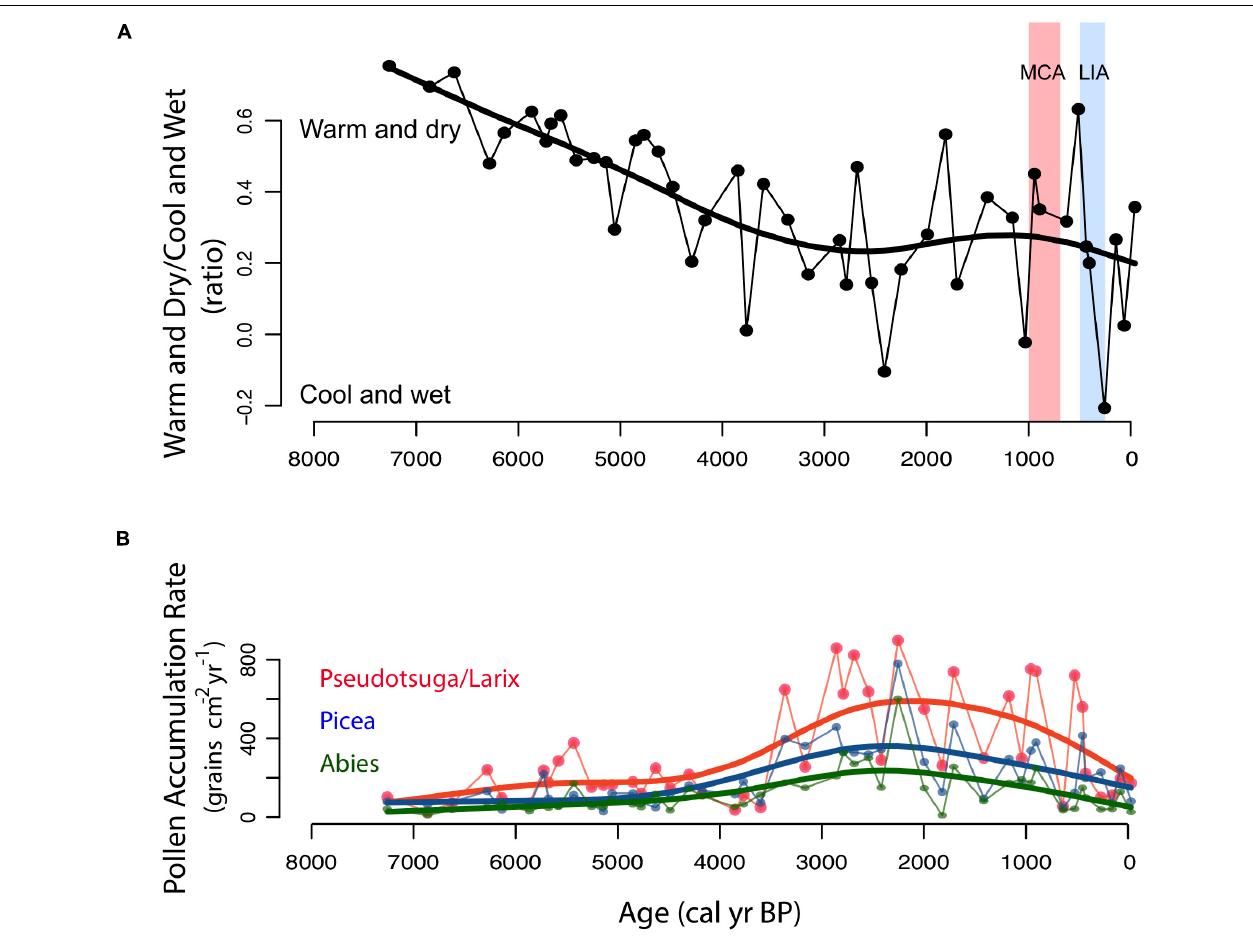
FIGURE 7 | Pollen data from select taxa from Black Lake sediments. (A) Ratio of warm and dry pollen taxa versus cool and wet pollen taxa calculated with the equation: (WD-CW)/(WD + CW). Red shading represents the Medieval Climate Anomaly (MCA, 1000–750 cal yr BP) and blue shading represents the Little Ice Age (LIA, 550–250 cal yr BP) (Mann et al., 2009). (B) PAR of Pseudotsuga/Larix, Picea, and